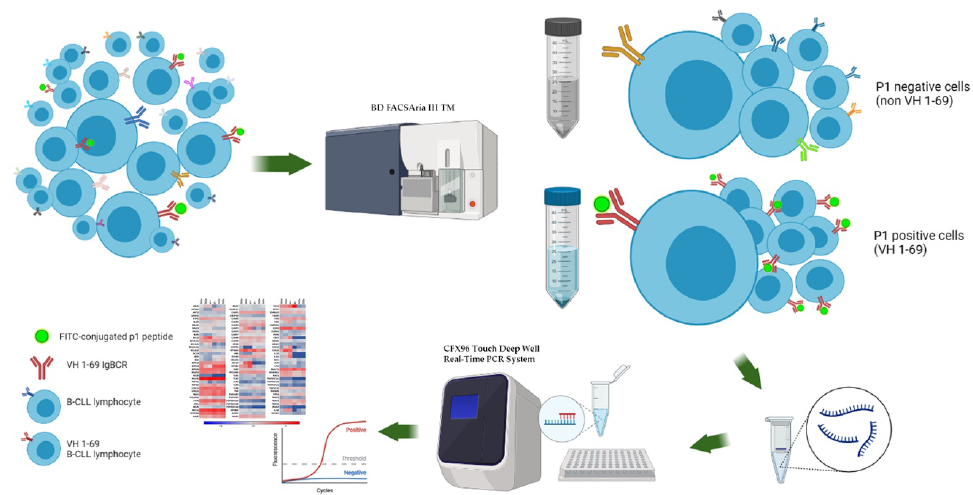
Figure 2. Representative workflow for the analysis of single tumor clones. The previously identified peptide p1 [16] was used as a probe to specifically target and isolate the IGHV1-69 clones among the total tumor population in the CLL1 and CLL5 patients. Two populations were obtained in each case: the p1 positive clones expressing an IGHV1-69 rearrangement, and the p1 negative clones carrying immunogenetically different IGHV gene rearrangements. Total mRNA was purified, retro-transcribed in cDNA, and analyzed by qRT PCR array for both cell populations from each patient.